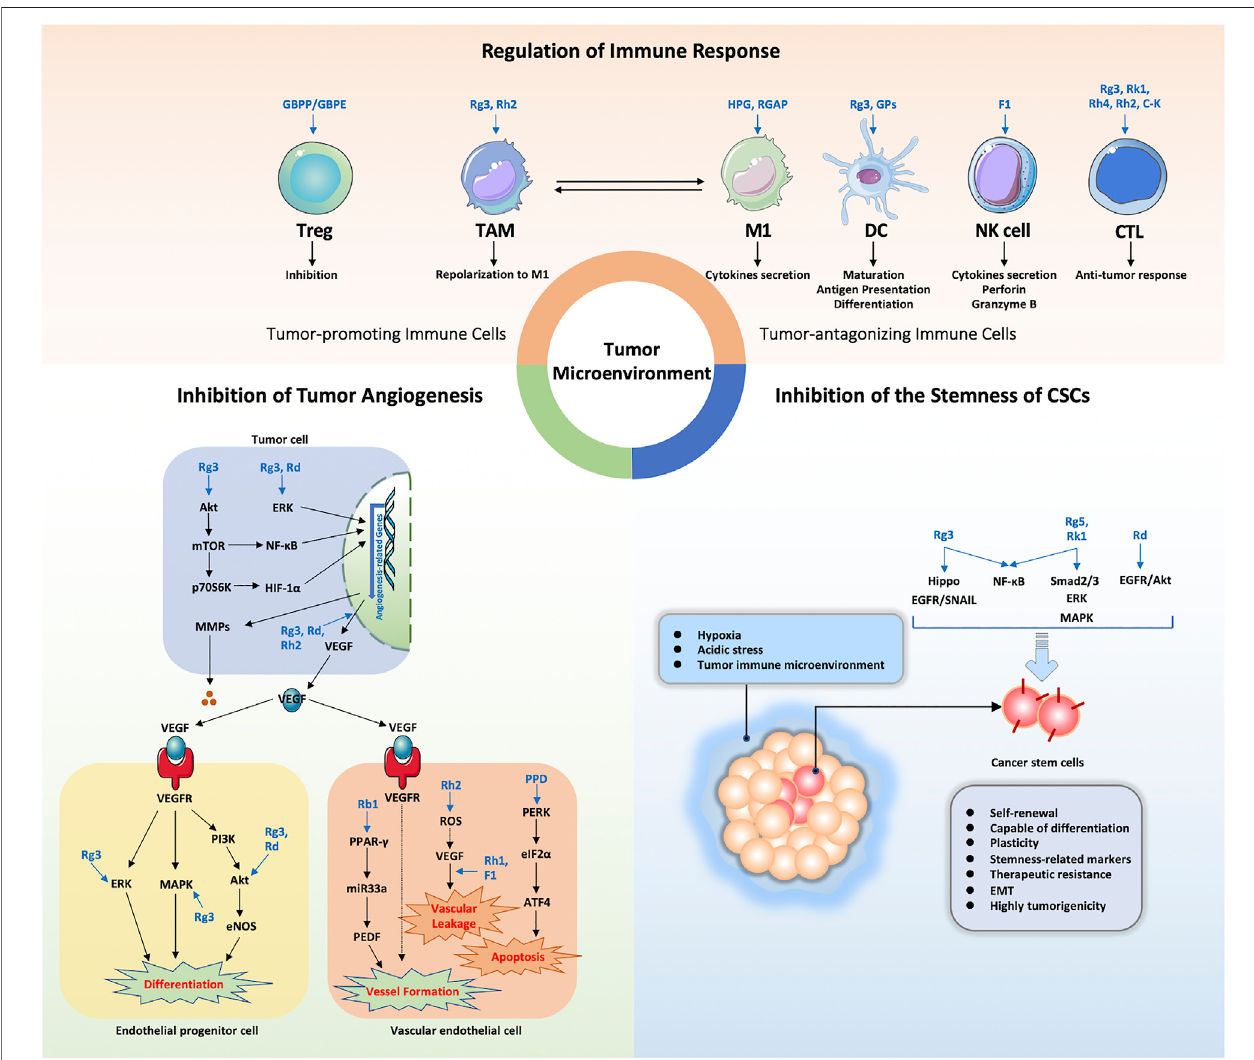
FIGURE3| SummaryofthefunctionaleffectsandmechanismsunderlyingTMEregulationbyginsengactiveingredientsviamultipletargets.HPG,heat-processed ginseng; RGAP, red ginseng acidic polysaccharide; GPs, ginseng polysaccharides; NK cell, natural killer cell; CTL, cytotoxic T lymphocyte.